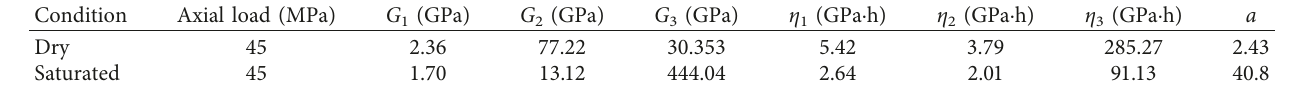
Table 3: Rheological parameters required for the HKCV model.